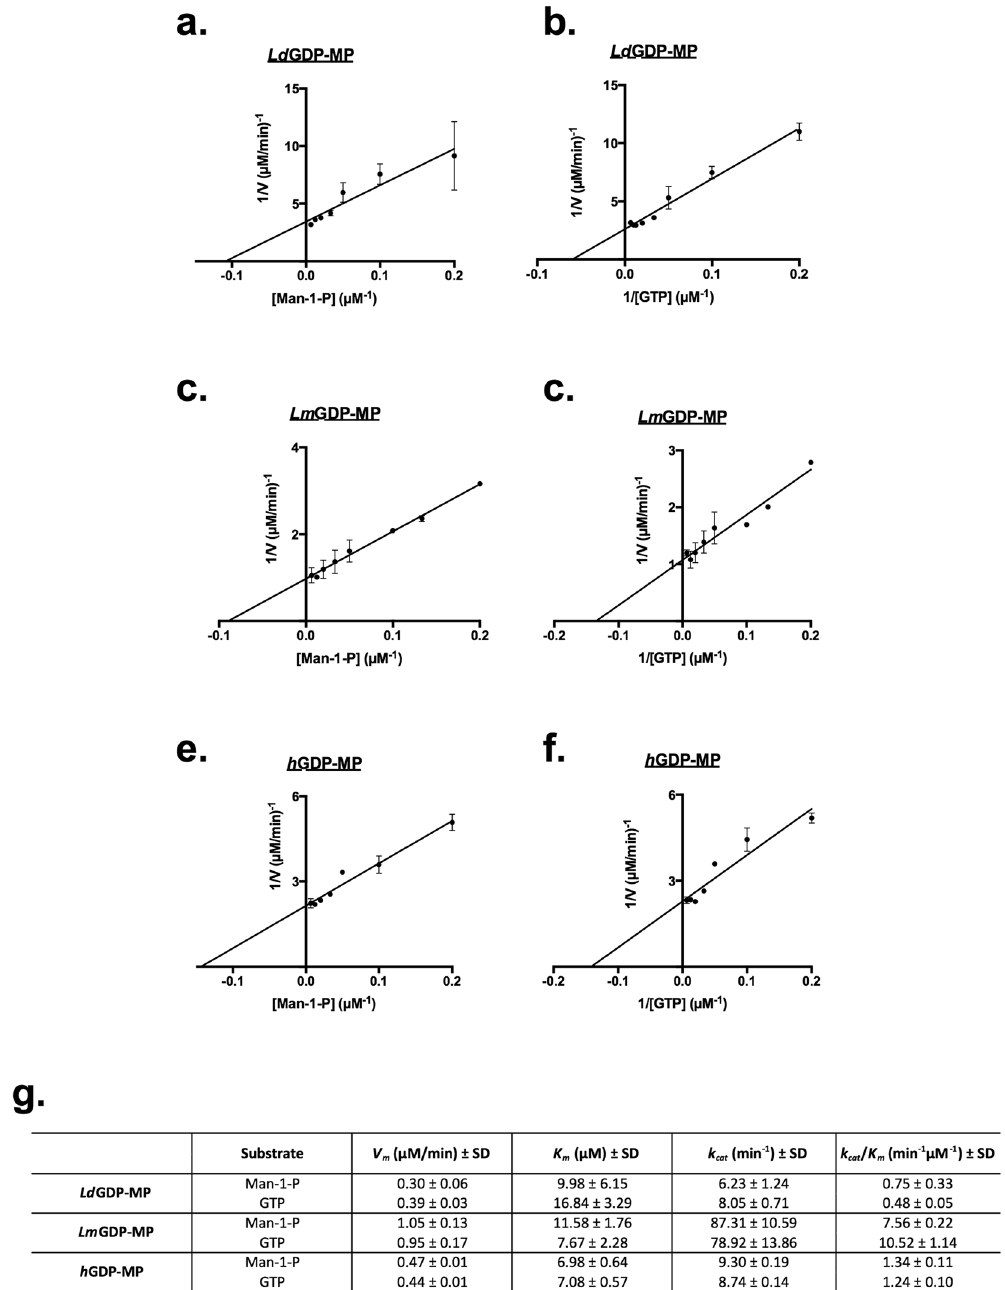
Figure 3. Determination of Ld GDP-MP, Lm GDP-MP and h GDP-MP kinetic constants. ( a,c,e ) Lineweaver Burk double reciprocal plots 1/V = f(1/[Man-1-P]) of Ld GDP-MP ( a ), Lm GDP-MP ( c ) and h GDP-MP ( e ). GTP concentration was held constant at 150 µ M for Ld GDP-MP and 80 µ M for Lm GDP-MP and h GDP-MP. The results expressed correspond to the mean of three independent experiments ± SD. ( b,d,f ) Lineweaver Burk double reciprocal plots 1/V = f(1/[GTP]) of Ld GDP-MP ( b ), Lm GDP-MP ( d ) and h GDP-MP ( f ). Man-1-P concentration was held constant at 150 µ M for Ld GDP-MP and 80 µ M for Lm GDP-MP and h GDP-MP. The results expressed correspond to the mean of three independent experiments ± SD. ( g ) Kinetic constants ( V m , K m , k cat , k cat / K m ) of Ld GDP-MP, Lm GDP-MP and h GDP-MP for both substrates Man-1-P and